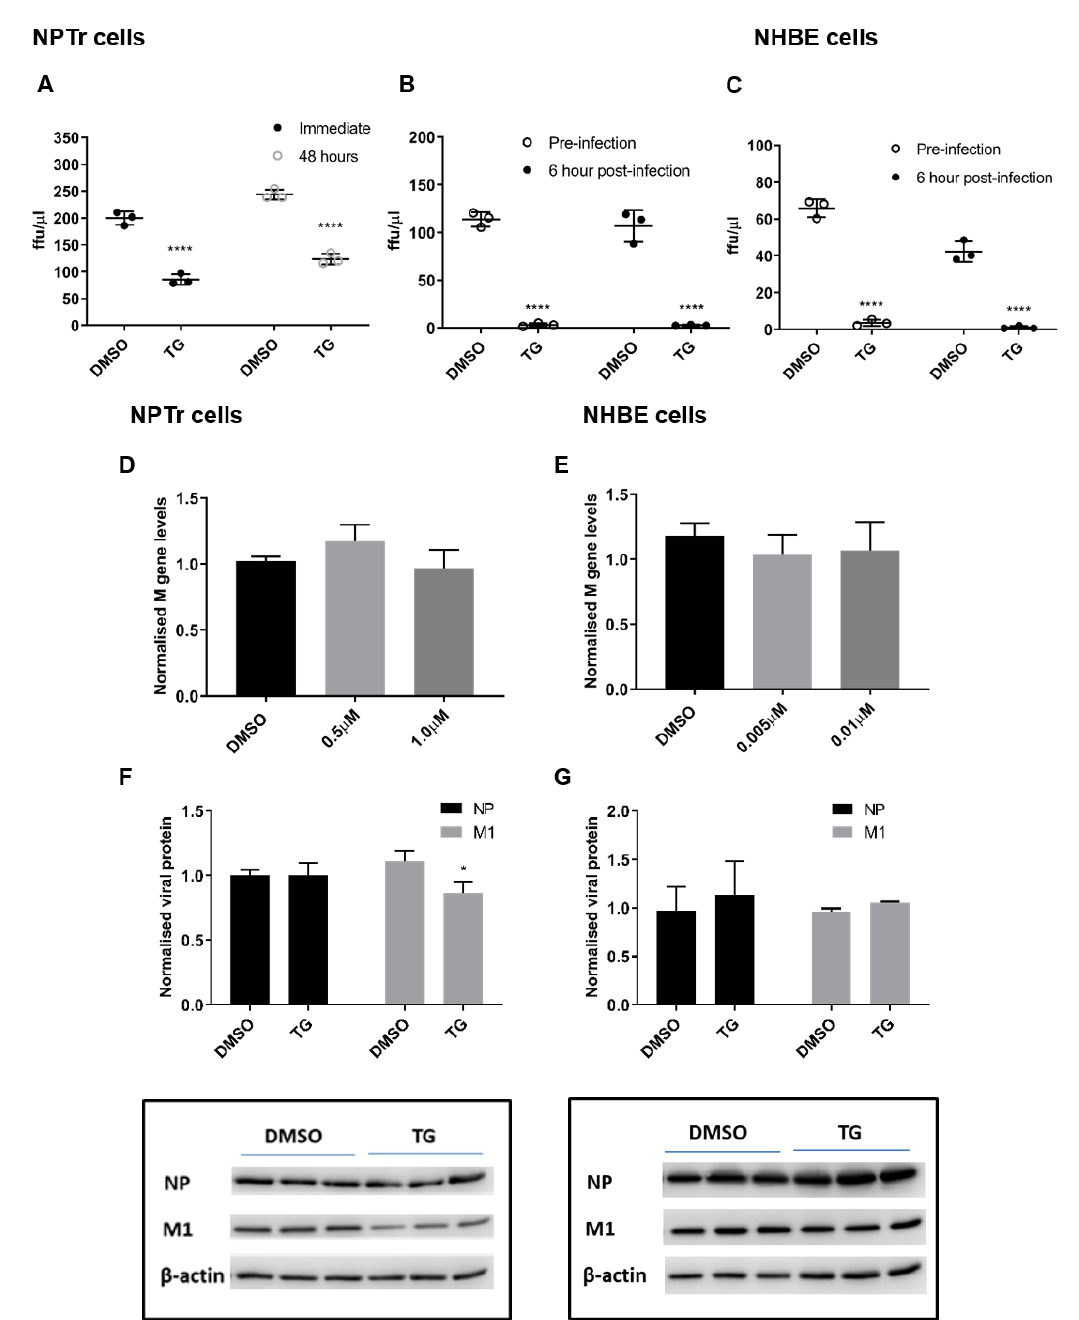
Figure 4. TG promptly induces an extended antiviral state targeting influenza virus post-translationally. ( A ) NPTr cells primed with 0.5 µ M for 30 min were immediately infected or further cultured for 48 h prior to infection with USSR H1N1 virus at 0.5 MOI for 24 h. Spun sns were used to infect MDCK cells for 6 h in FFAs. Significance determined by paired t-test within each time point. ( B ) NPTr and ( C ) NHBE cells were incubated with TG (0.5 and 0.01 µ M, respectively) for 30 min and immediately infected (TG pre-infection) or were first infected for 6 h followed by TG exposure for 30 min (TG post-infection). NPTr and NHBE cells were infected with USSR H1N1 virus at 0.5 and 1.0 MOI, respectively. TG pre-primed cells